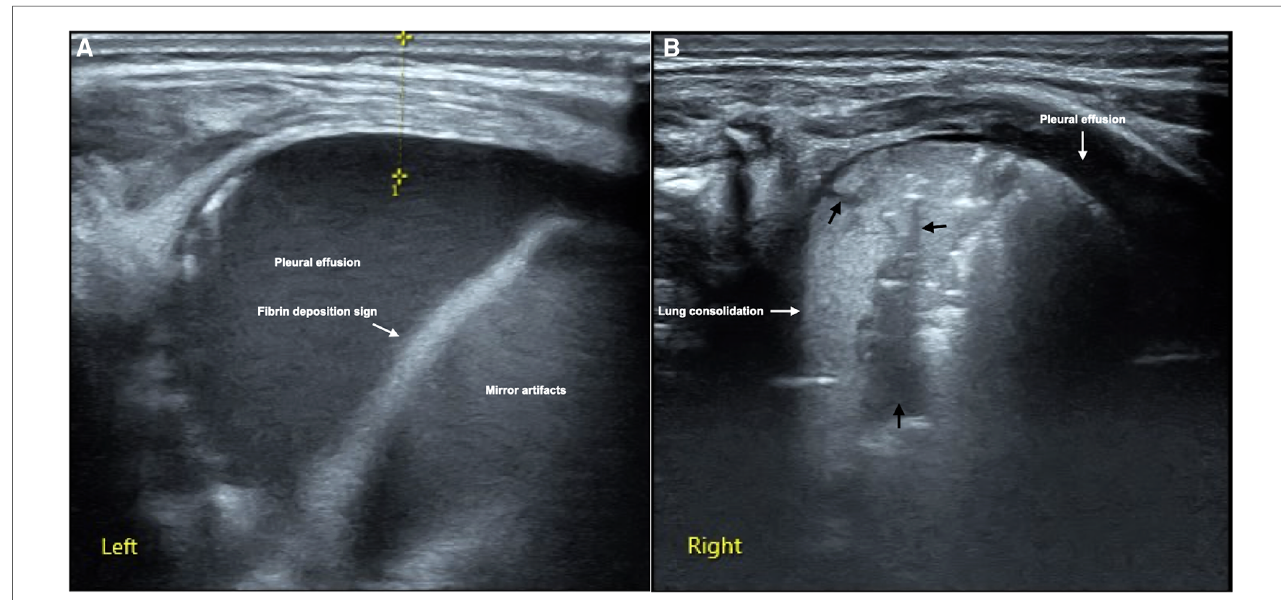
FIGURE 1 LUS manifestations of neonatal PH. This is a male term infant delivered by cesarean section at gestational age 40 +3 weeks with birth weight of 3,890 g. He was admitted to NICU at 10 min of birth due to fetal distress, severe birth asphyxia and dyspnea after resuscitation. Physical examination found that the infant ’ s respiratory rate increased by more than 70/min with signi fi cant retraction, palpable wet rales on auscultation. LUS showed massive pleural effusion and mirror artifacts, and fi brin deposition sign in the left thoracic cavity ( A ), while the right lung should signi fi cant lung consolidation accompanied with fl uid bronchograms (thick black arrows), and a small amount of pleural effusion ( B ). 30 ml of hemorrhagic effusion was extracted from the left thoracic cavity by pleural puncture.